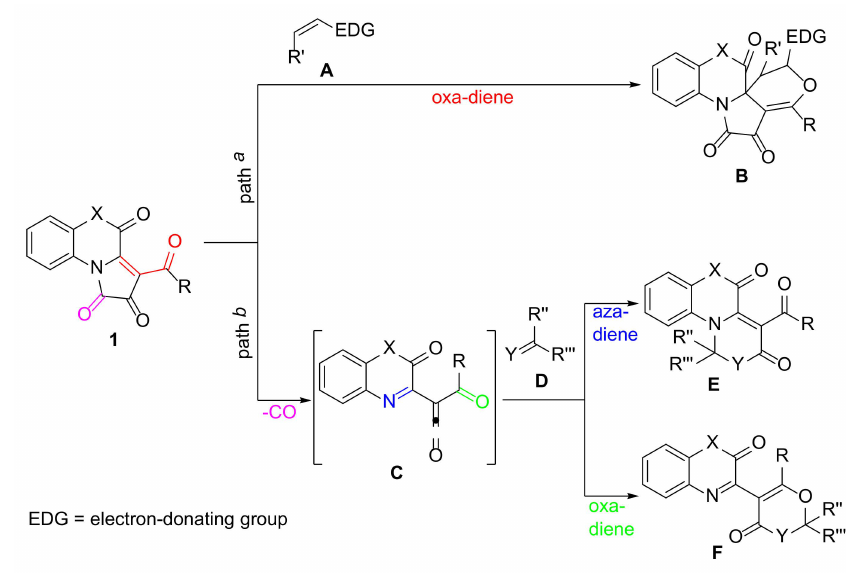
Scheme 1. Modes of participation of FPDs 1 as heterodienes in